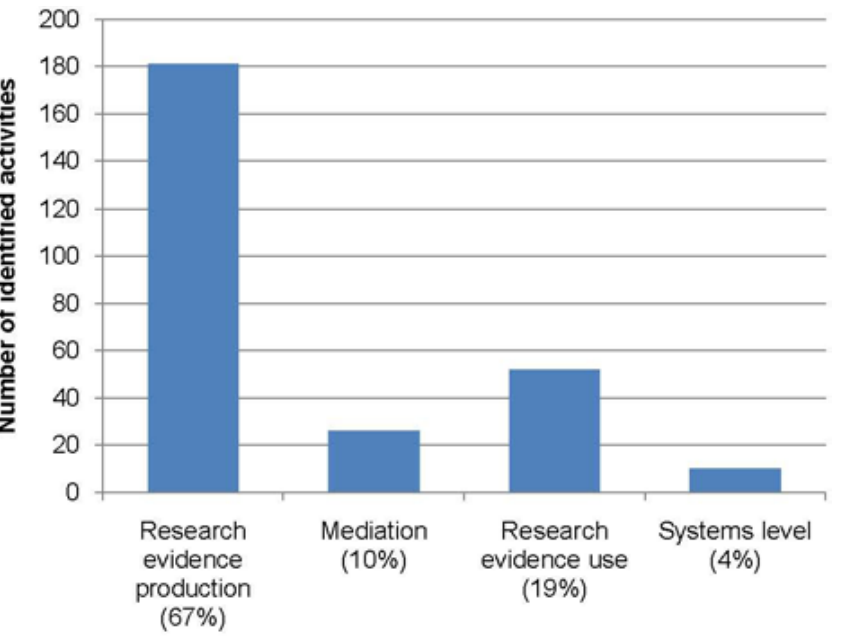
Figure 10: The focus of European linking activities within the research evidence production-to-use